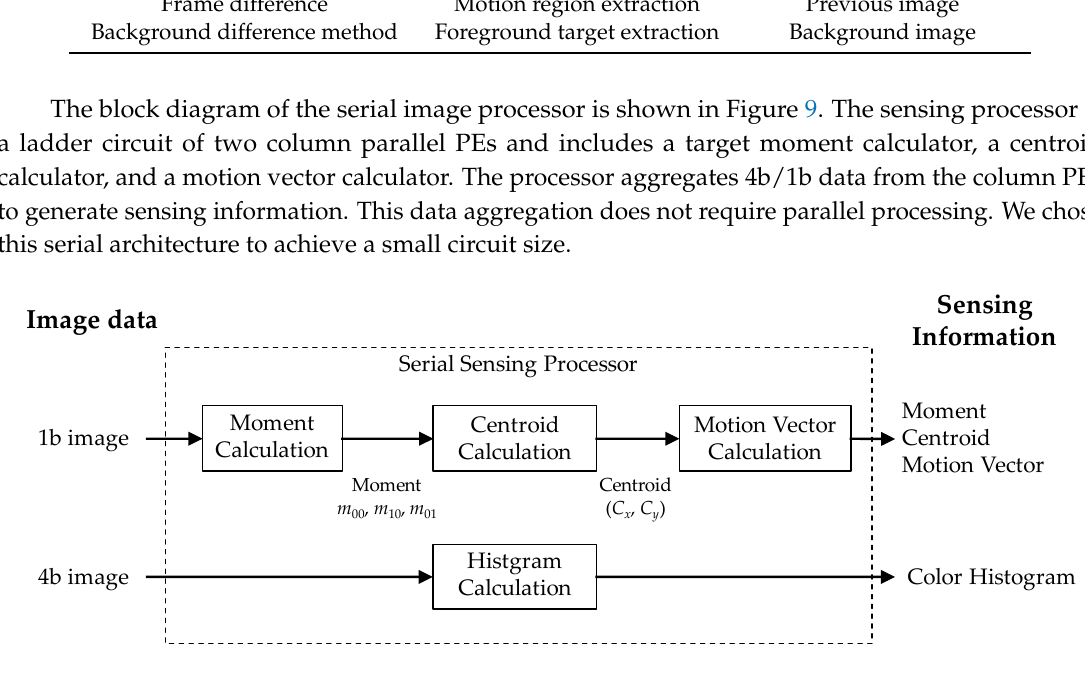
Figure 9. Block diagram of the serial image processor.